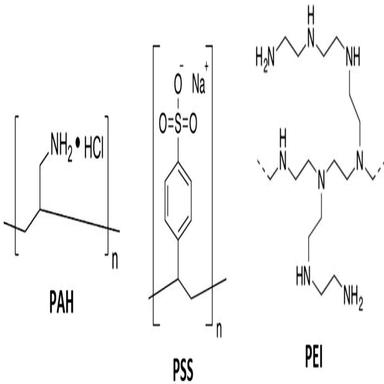
Chemical structure of the polyelectrolytes used in this work.